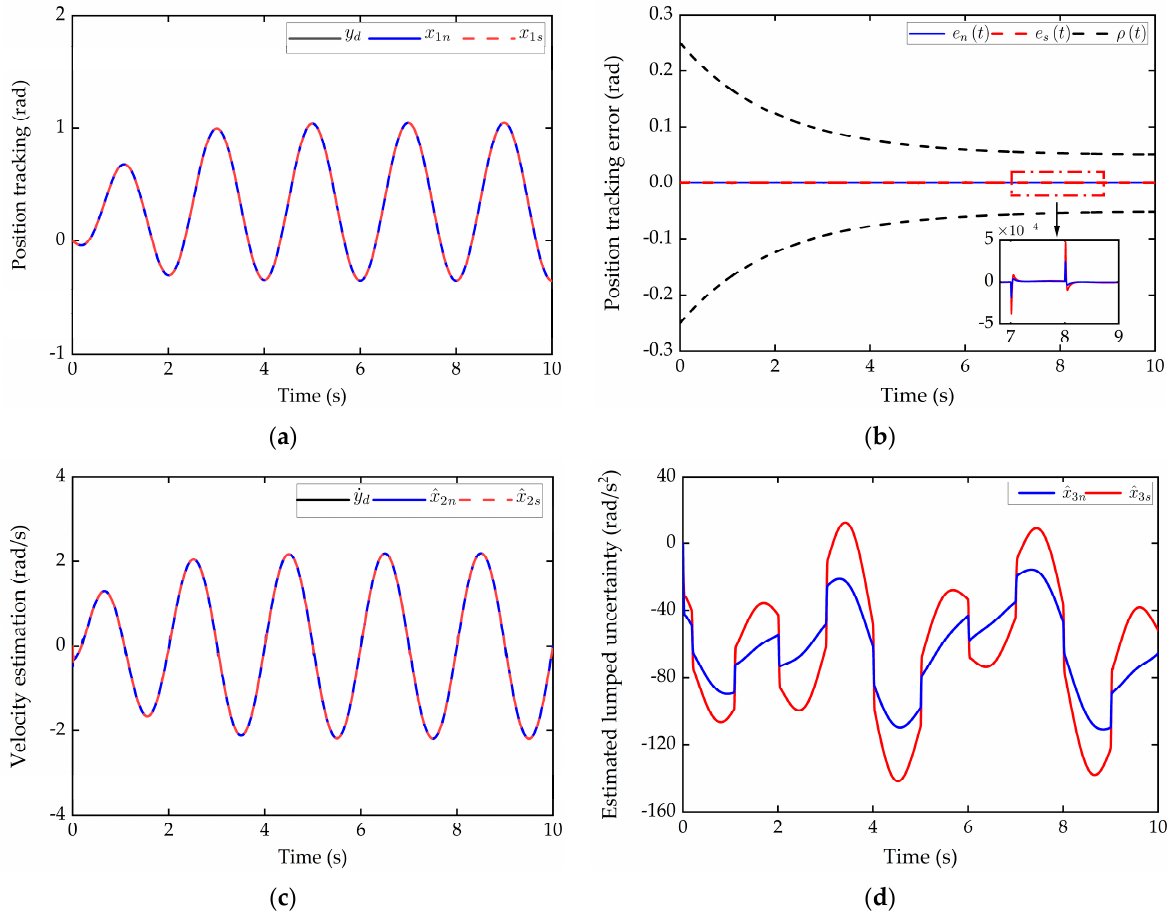
Figure 5. Position-tracking performance of slow motion with the proposed PP-NFTSMC-ESO controller. ( a ) Position response. ( b ) Position-tracking error. ( c ) Velocity estimation. ( d ) General disturbance estimation. Table 6. The maximum steady-state tracking error of the four